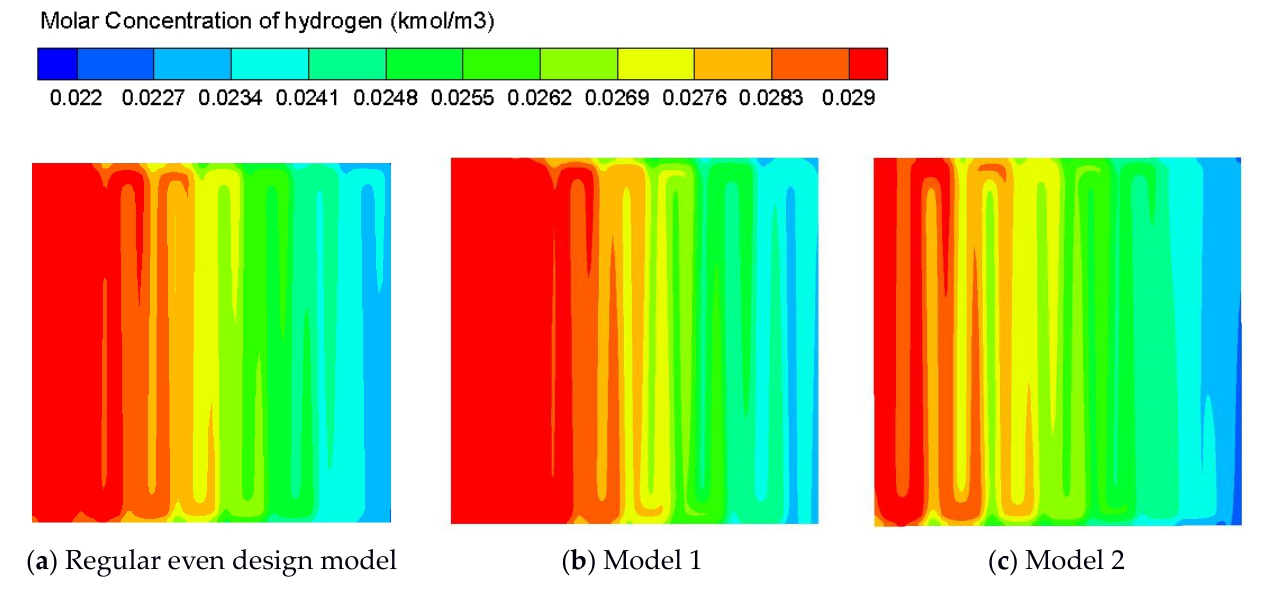
Figure 4. H 2 concentration distribution on the anode gas diffusion layer. Table 5. Standard deviation of the hydrogen concentration distribution.